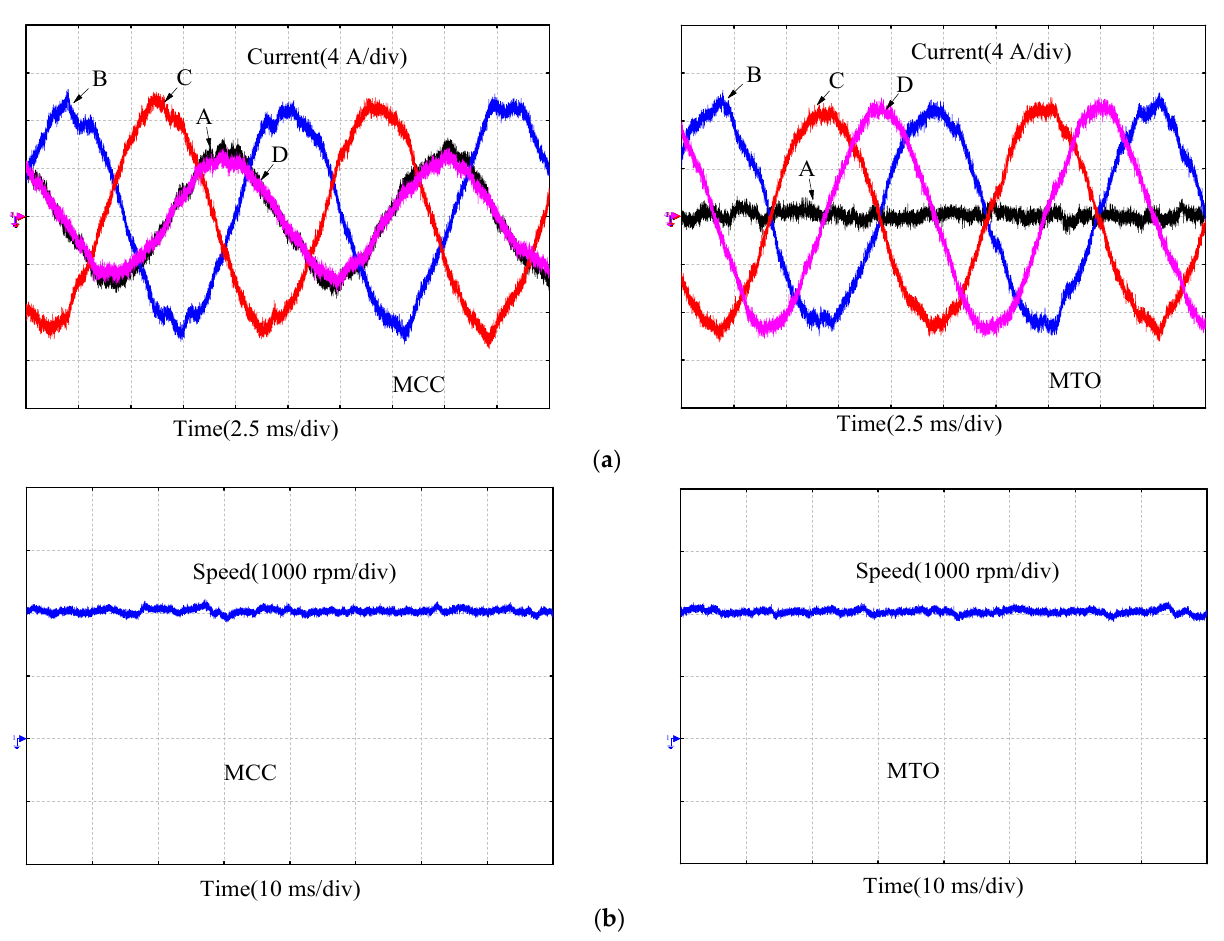
Figure 16. Motor waveform during F-phase open circuit fault. ( a ) Current waveform. ( b ) Speed waveform. ( c ) Fault characteristic value.